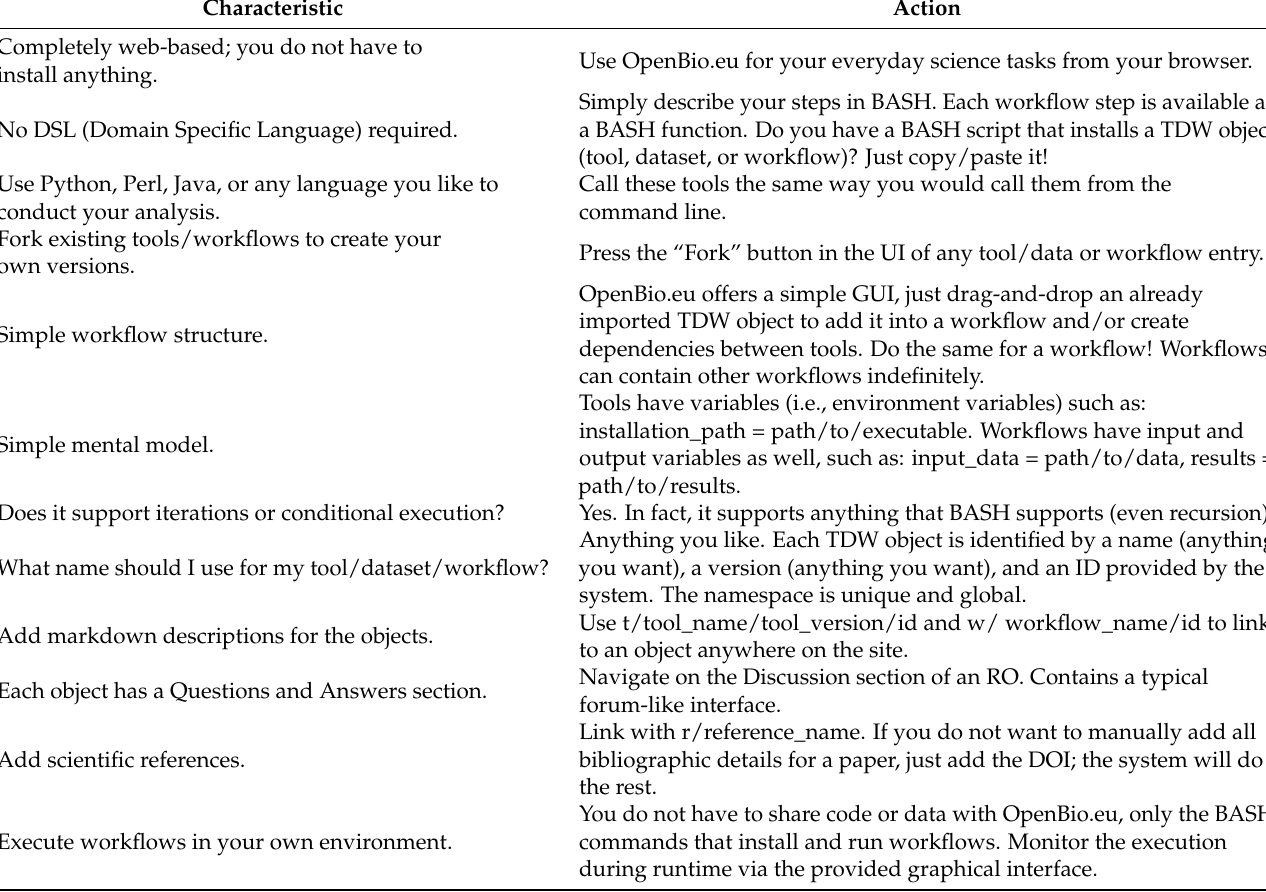
Table 5. Basic characteristics of OpenBio.eu and actions to